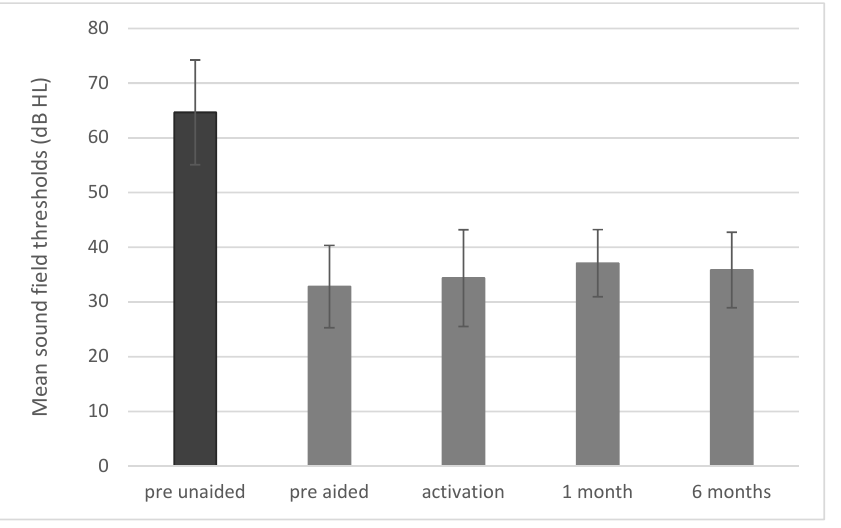
Figure 6. Sound field thresholds. All differences between pre-unaided and all other conditions are statistically significant at p < 0.001. The bars represent mean scores, the error bars are standard deviations.